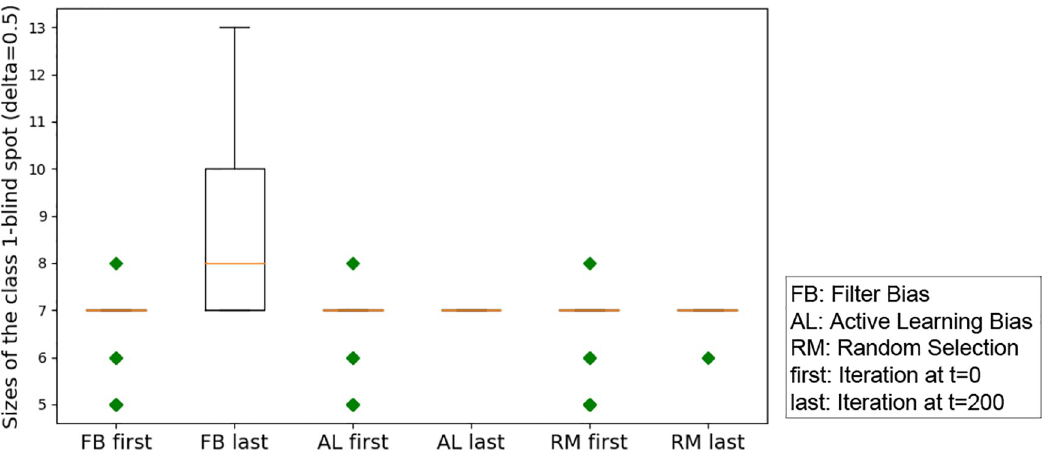
Fig 7. Box-plot of the size of the class-1-blind spot for all three iterated algorithmic bias forms. In this figure, the x-axis is the index of the three forms of iterated algorithms biases. As shown in this box-plot, the initial class-1-blind spot is centered at 7. This is because the 200 randomly selected initial points from both classes force the boundary to be similar regardless of the